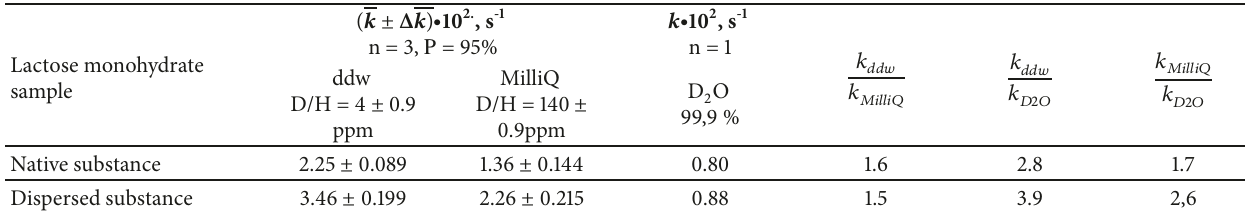
Figure 2: The laser obscuration values as solubility time function of native (a) and dispersed (b) lactose monohydrate in waters with the different D/H ratio: 1: ddw, 2: MiliQ, and 3: D 2 O. Table1:ThelactosemonohydratesolubilityrateconstantsandkineticisotopiceffectinwaterwithdifferentD/ X ratiosfornativeanddispersed